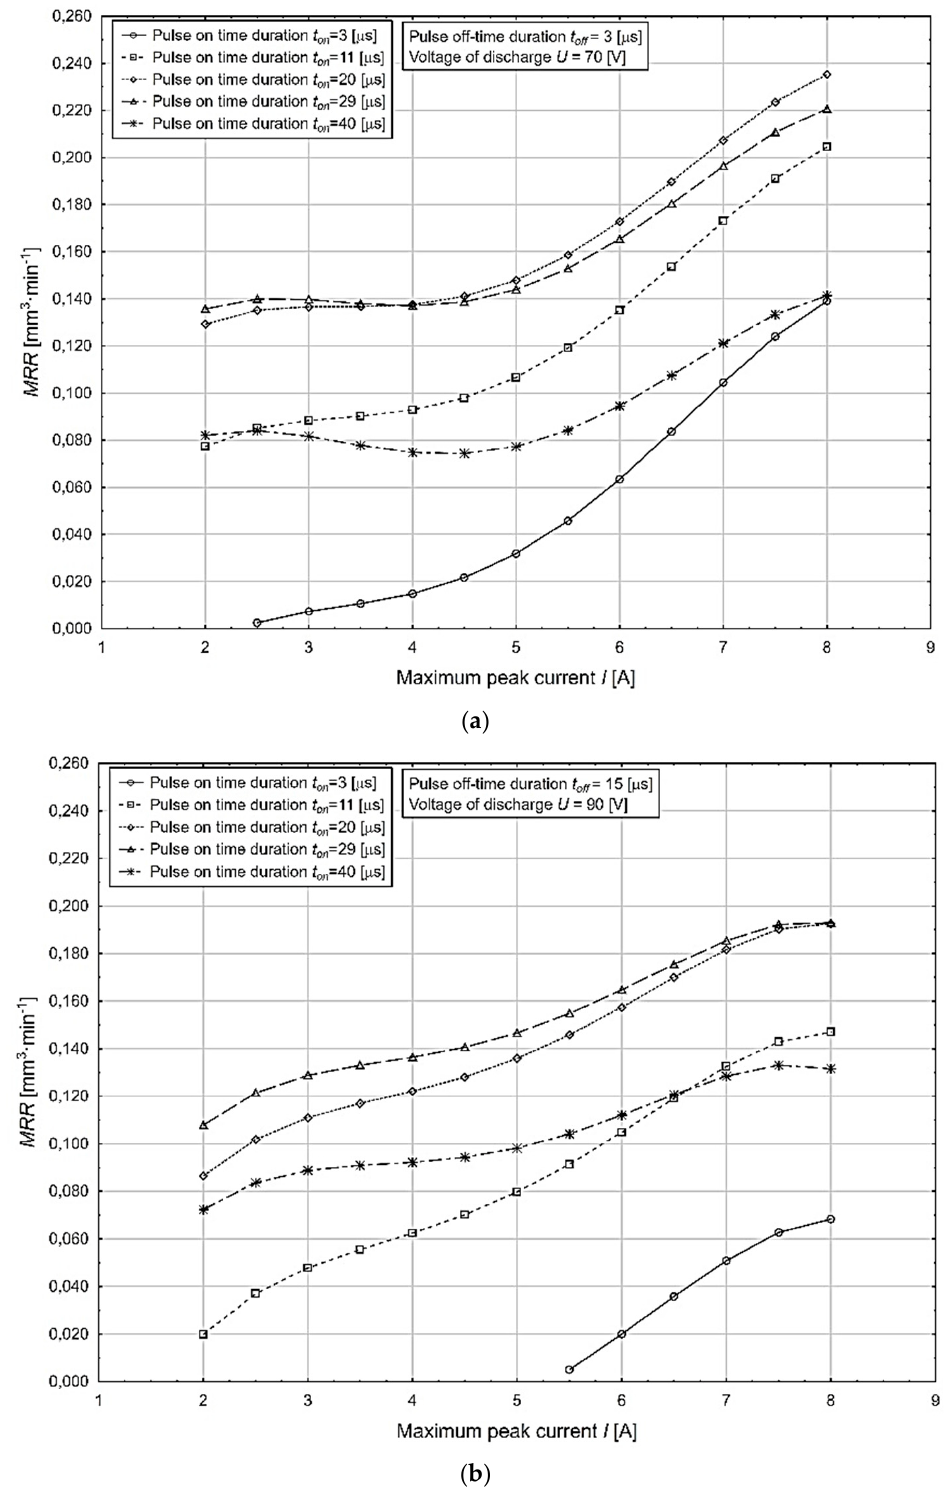
Figure 3. Dependence of the output power parameter of the MRR process on the change in the value of the maximum peak current I parameter at different values of t on , t off , and U . ( a ) Impact on MRR at minimum values of the parameter t off and U. ( b ) Impact on MRR at maximum values of t off and U.